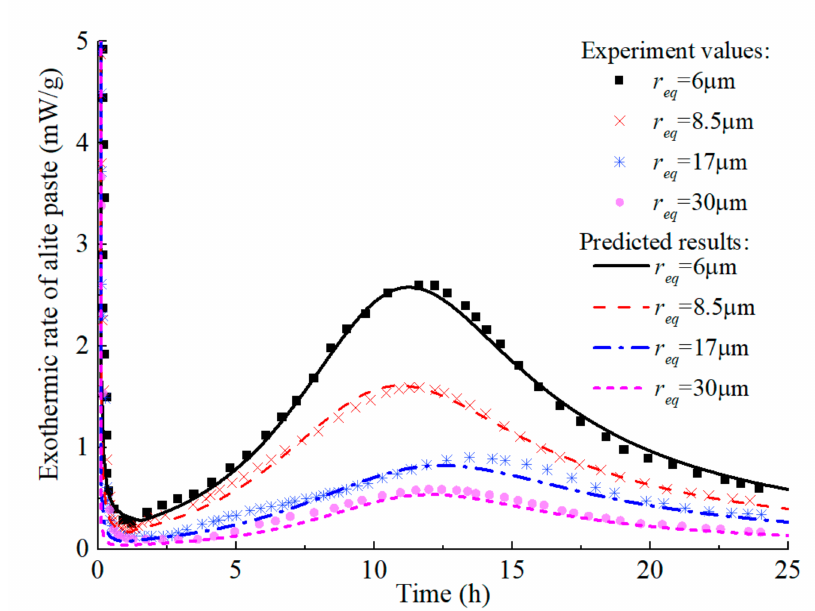
Figure 4. Isothermal calorimetric test values and prediction curves of alite in early age.